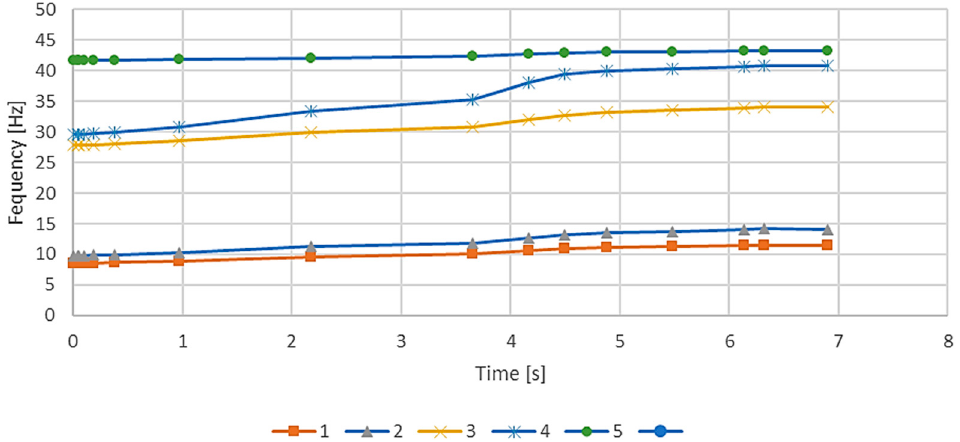
Figure 32. Total rocket mass over first 7 s of flight.